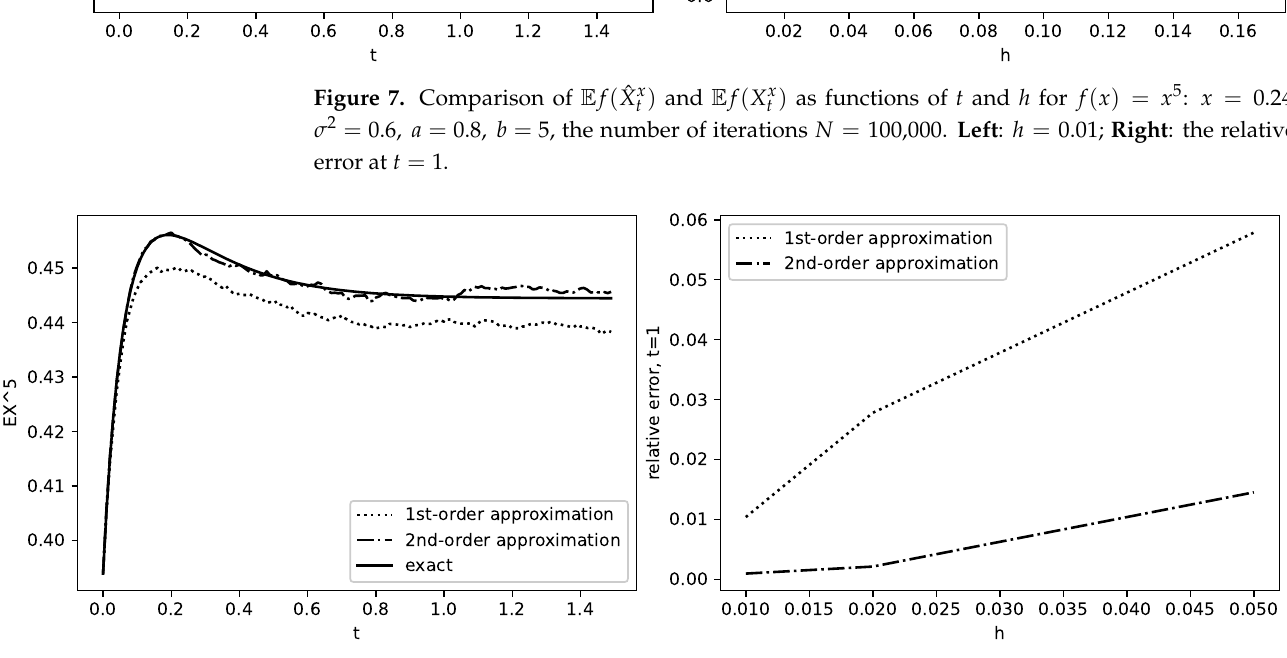
Figure 8. Comparison of E f ( ˆ X x σ 2 = 2, a = 4, b = 5, the number of iterations N = 100,000. Left : h = 0.01; Right : the relative error at t =